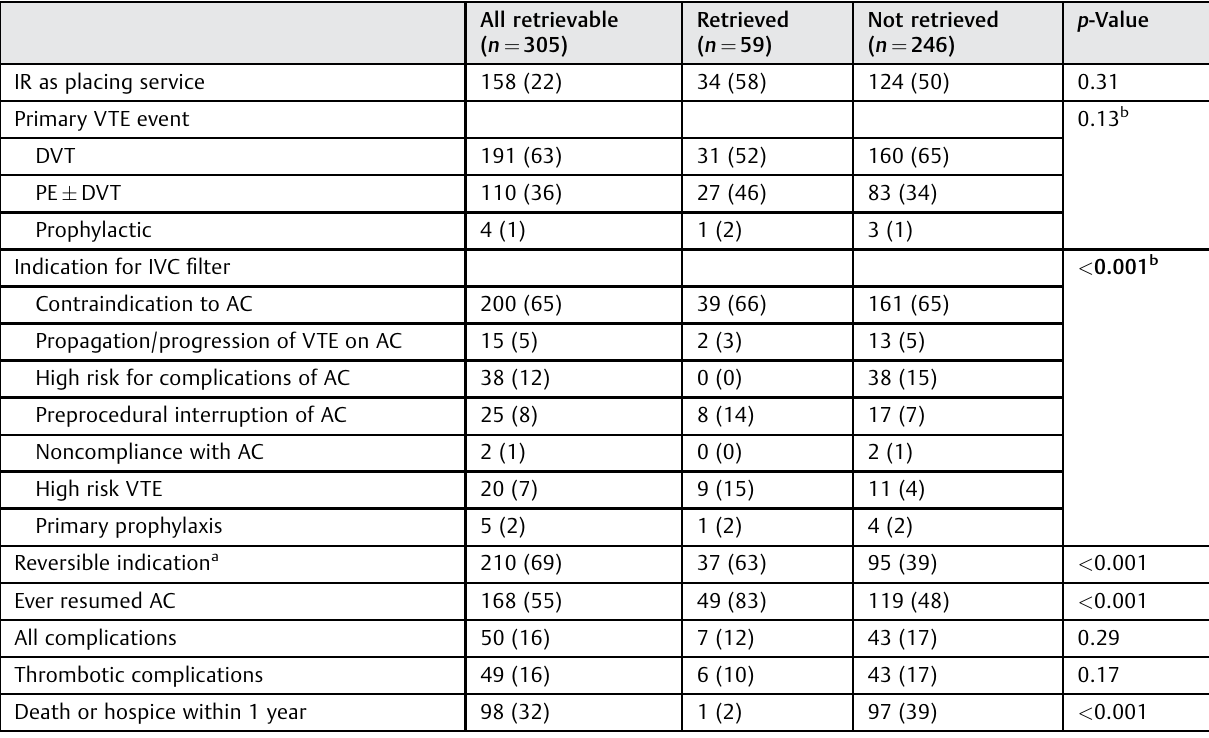
Table 3 Indications and complications of retrieved and nonretrieved